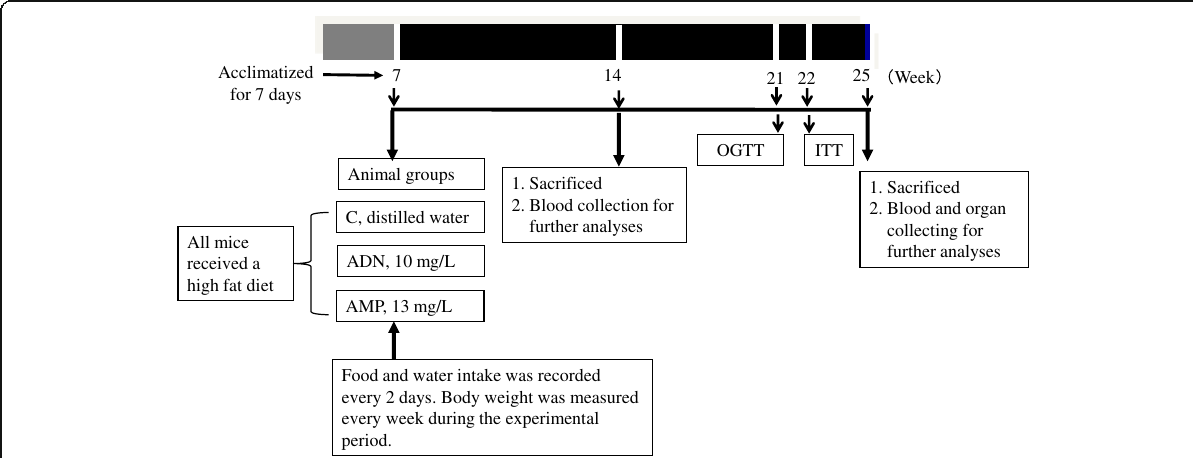
Fig. 1 Workflow diagram of the experiments. C, control group; ADN, adenosine group; AMP, adenosine-5 ′ -monophosphate group; OGTT, oral glucose tolerance test; ITT, insulin tolerance